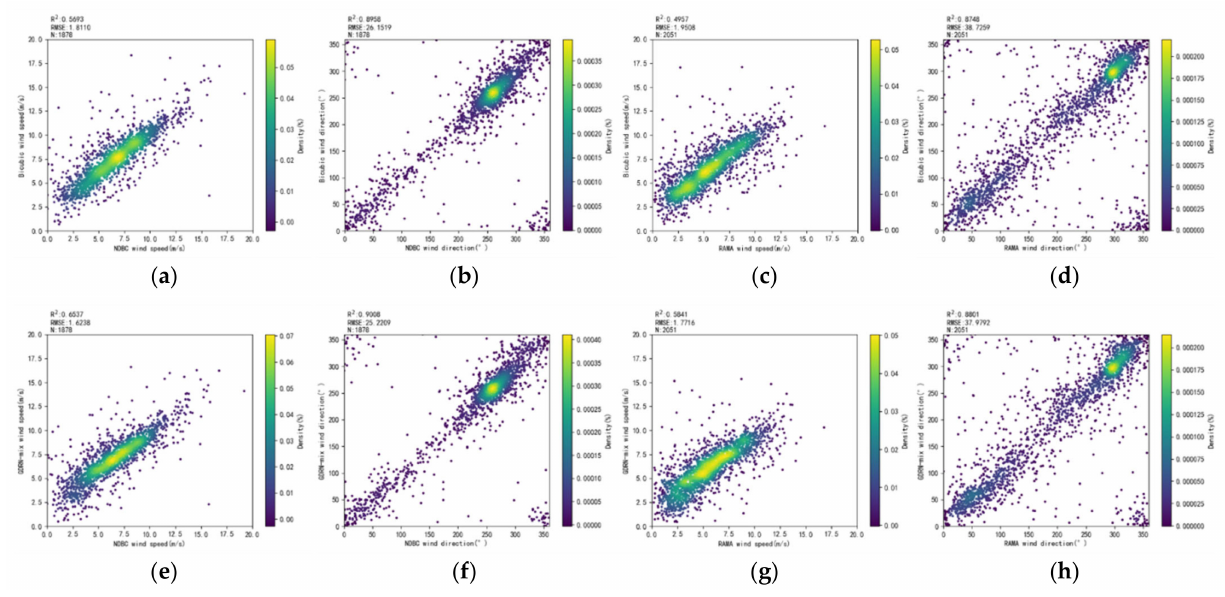
Figure 9. The validation results of sea surface wind with in situ buoy measurements in scatter plots with RMSE and R 2 for the 16 × downscaling reconstructed high-resolution results at 0.015625 ◦ on the test dataset, from left to right in each row are for the wind speed and the wind direction in Region 1 and Region 2 as shown in Figure 1, respectively: ( a – d ) The results for the bicubic interpolation downscaling; ( e – h ) The validation for the downscaling using model adaptation by sampling both unpaired SSW and synthetic paired SSW.